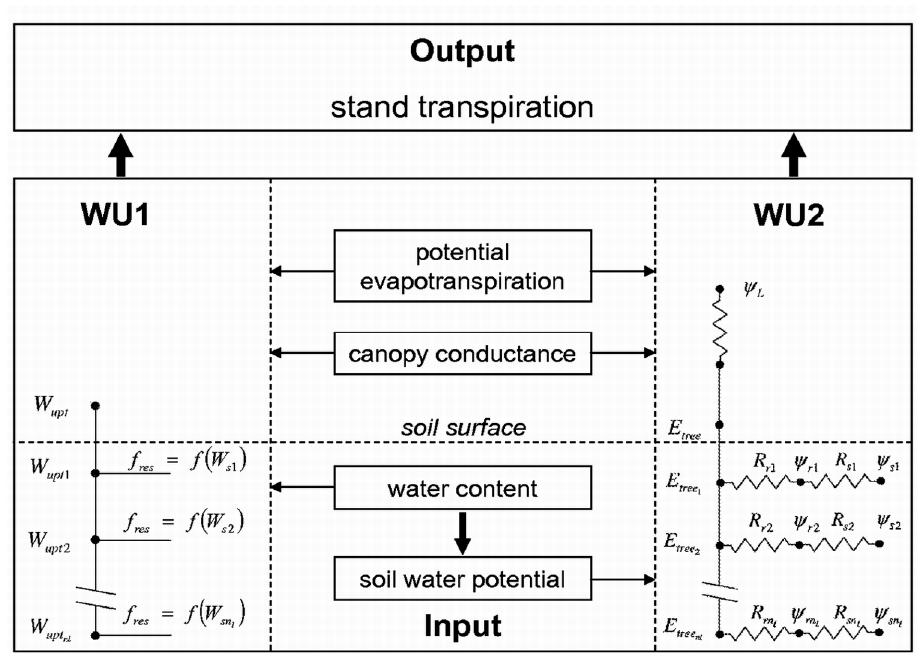
Figure 1. Schematic overview of the simulated components for WU1 and WU2. With W upt and E tree = sum of water uptake of a tree over n l number of soil layers, W s = soil water content, R r = root resistance, R s = soil resistance, ψ L = leaf water potential, ψ r = root water potential, ψ s = soil water